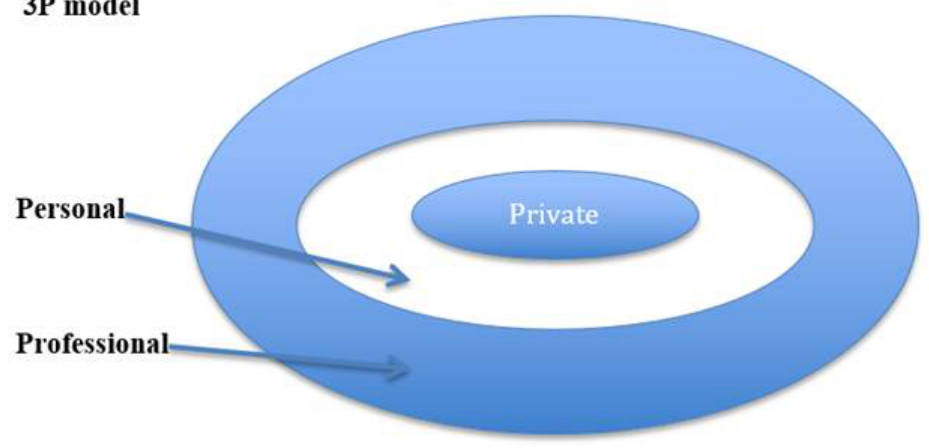
Figure 1. 3P Model [© 2010, E. Jappe].